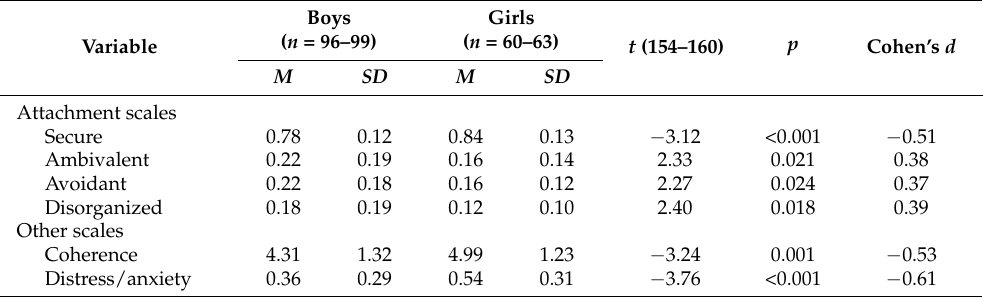
Table 5. Means, Standard Deviations, and t-test Statistics for the Scales comparing Boys and Girls in the Clinical